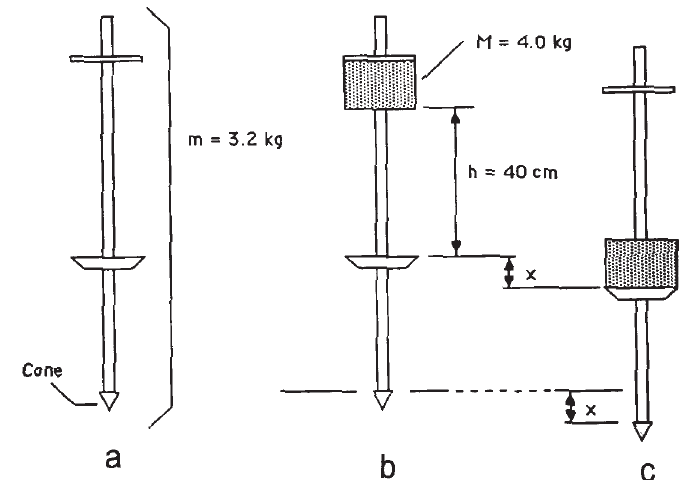
Figure 1. Stolf penetrometer: frame, m, weighing 3.2 kg (a); position of the penetrometer components before dropping impact weight M (b); location of the penetrometer frame m and impact cylinder M after impact (c). M moves the distance h + x; m moves the distance